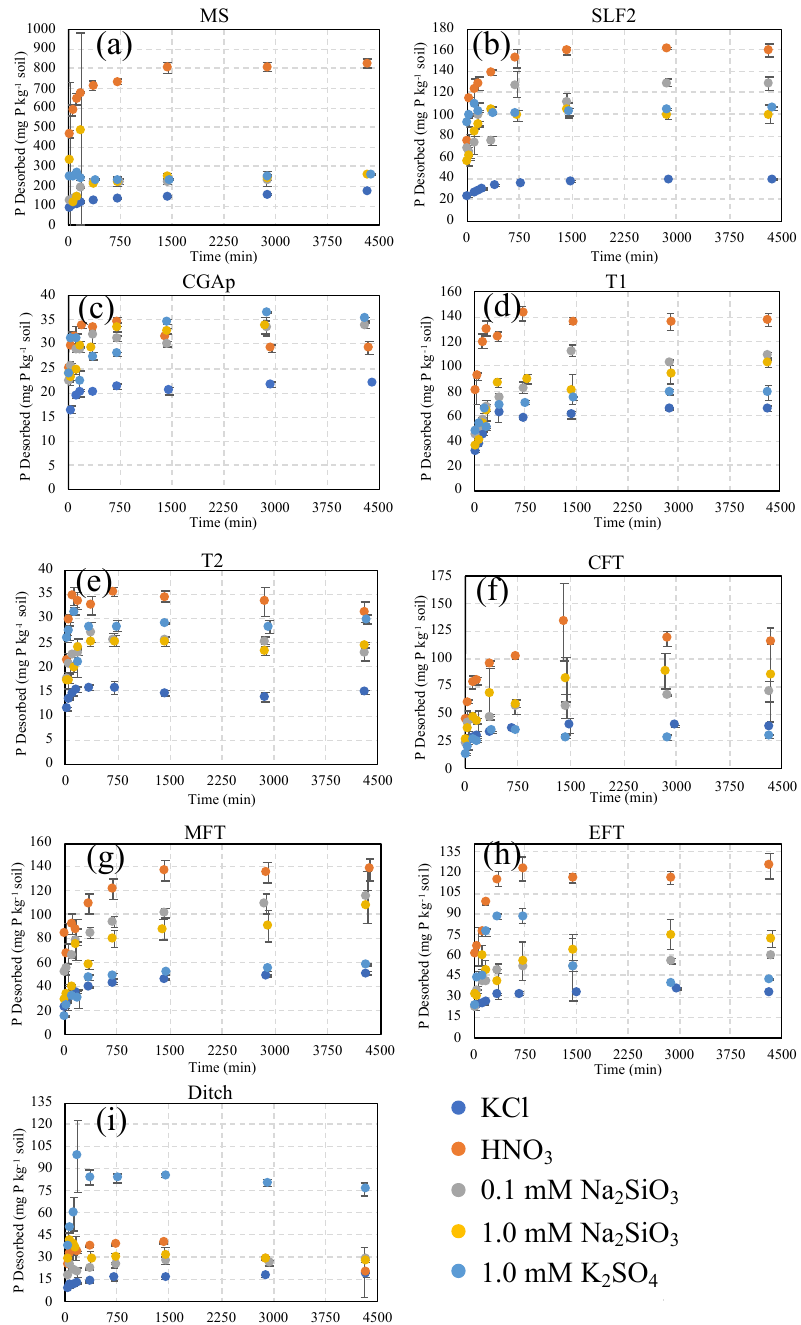
farm; and CFT (center field transect), MFT (middle field transect), EFT (edge field transect), and Ditch are agricultural soil samples from a third farm along a transect.